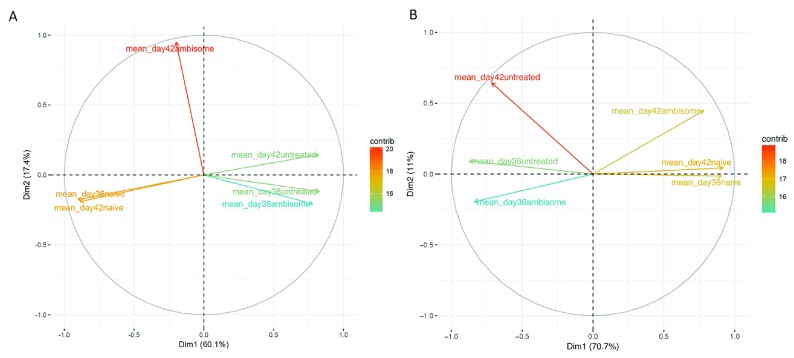
Principal component analysis comparing
L. donovani infected, AmBisome
®-treated
L. donovani-infected and naïve mice BALB/c mice.
A and
B. Eigen values were generated using the normalised expression values for differentially expressed genes in spleen (
A) and liver (
B). PCA analysis was performed in R using the prcomp package and the percentage contribution each condition (treatment and infection status) has to the expression value/ eigenvalue used to summarise the data; and the directionality of the first two principle components is shown as a biplot. The percentage of the variability in the data explained by first two components is the sum of the percentages given on both the x and y axis.